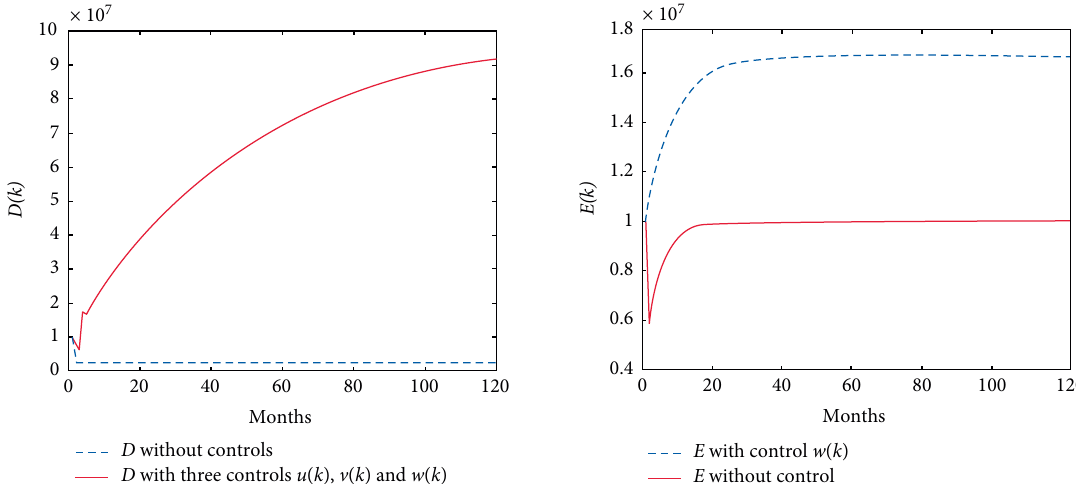
Figure 5: The evolution of the number of diabetics without complications with three controls 𝑢